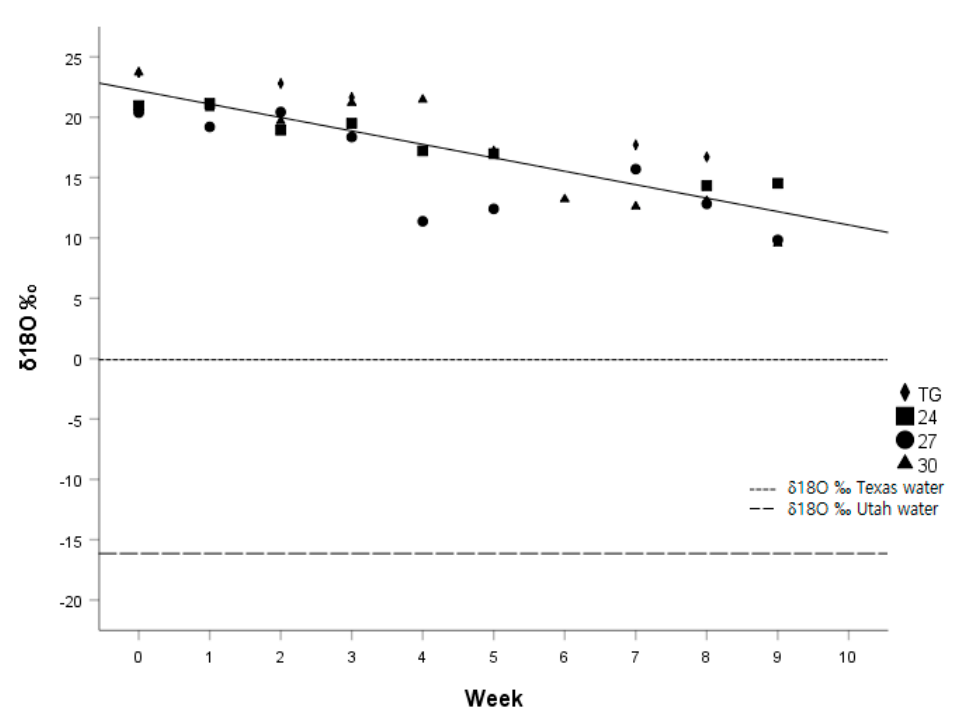
represent snakes allowed to freely thermoregulate. The short-dashed line represents the δ D value of the water they were given previous to the experiment in Texas ( − 0.5‰) and the long-dashed line represents the δ D value of the water they were given during the experiment in Utah ( − 119.8‰).